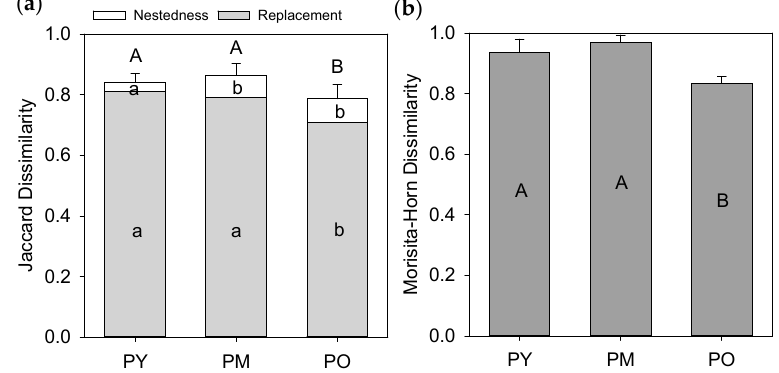
Figure 6. Mean pair-wise dissimilarity between natural forest transects and transects of young plantations (PY), medium-aged plantations (PM) and old to mature plantations (PO) in forest interiors. ( a ): Presence/absence-based Jaccard dissimilarity partitioned into the replacement and nestedness component according to Baselga [50]; ( b ): the abundance-based Morisita-Horn Index. Different lowercase letters indicate significant differences in replacement and nestedness component among forest types. Different uppercase letters indicate significant differences for the overall dissimilarity indices between forest types.